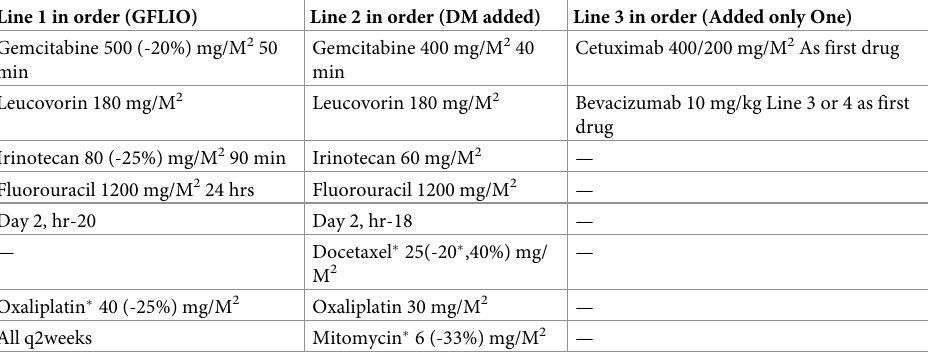
Table 1. Sequential treatment for advanced gastrointestinal